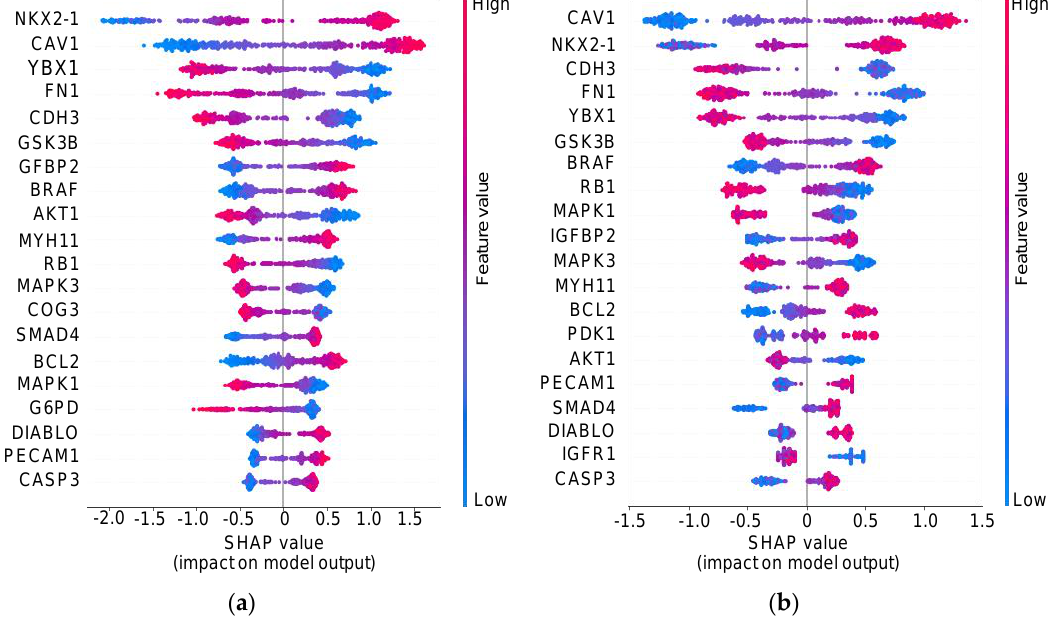
Figure 6. SHapley Additive exPlanations (SHAP) summary plot. ( a ) The plot shows the SHAP value of XGBoost magnitudes across all samples. The color represents the feature values (red represents high and blue represents low). ( b ) The plot shows the sum of SHAP value of LightGBM.